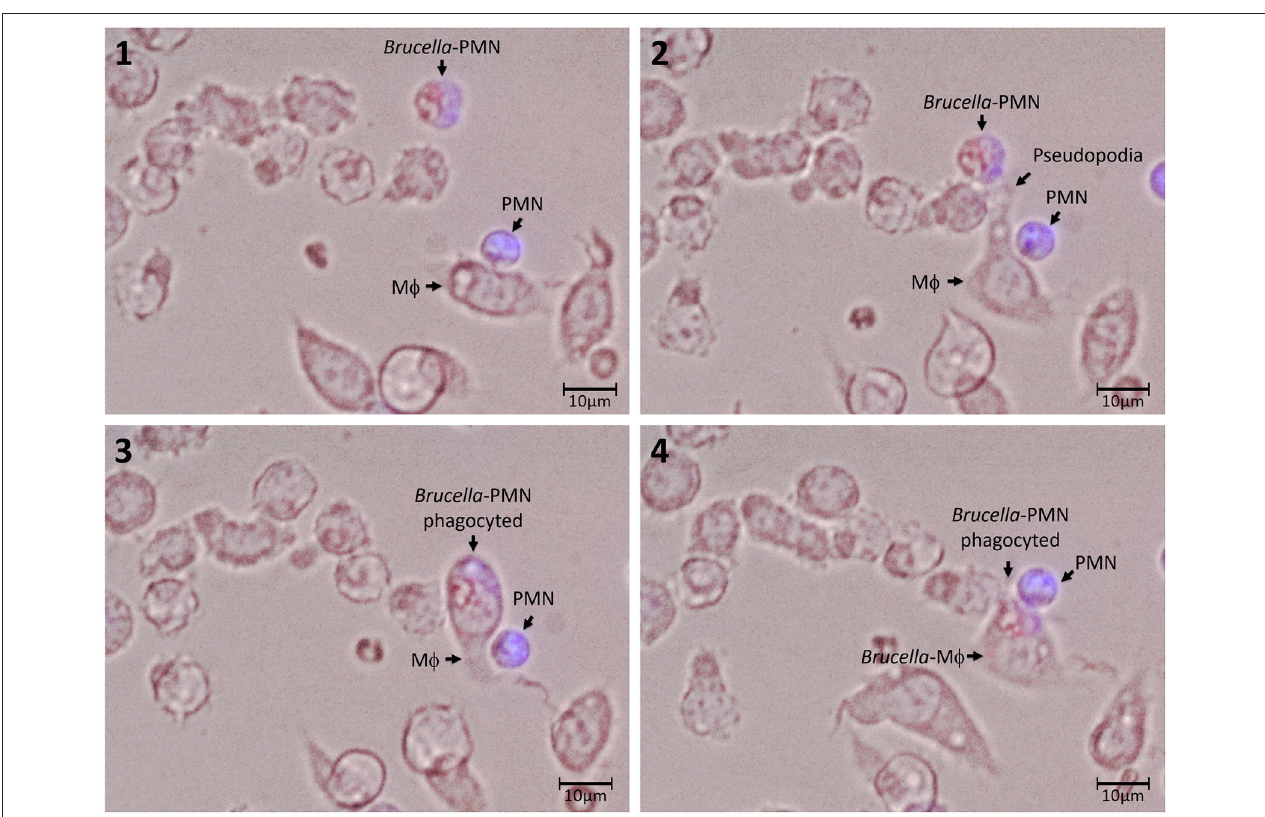
FIGURE 3 | Association and uptake of B. abortus -infected PMN by M φ s. PMNs were incubated with B. abortus -RFP (red) (MOI of 50) for 1.5h; then, cells were pelleted and washed with PBS to remove extracellular bacteria. Brucella- infected-PMNs were suspended in DMEM without gentamicin and added to RAW M φ s monolayers (5 × 10 3 ) at a rate of 1:1 and incubated for 10min at 37 ◦ C. After this period, the infected M φ monolayers were washed and suspended in DMEM and incubated for up to 5h. Infected PMNs were stained with Hoescht (blue). Cells were photographed and analyzed under Cytation 3 Cell Imaging Multi-Mode Reader (BioTek) using the appropriate color filter channel. Numbers 1 to 4 correspond to the order in the which images were capture very every 20min. These experiments were repeated at least three